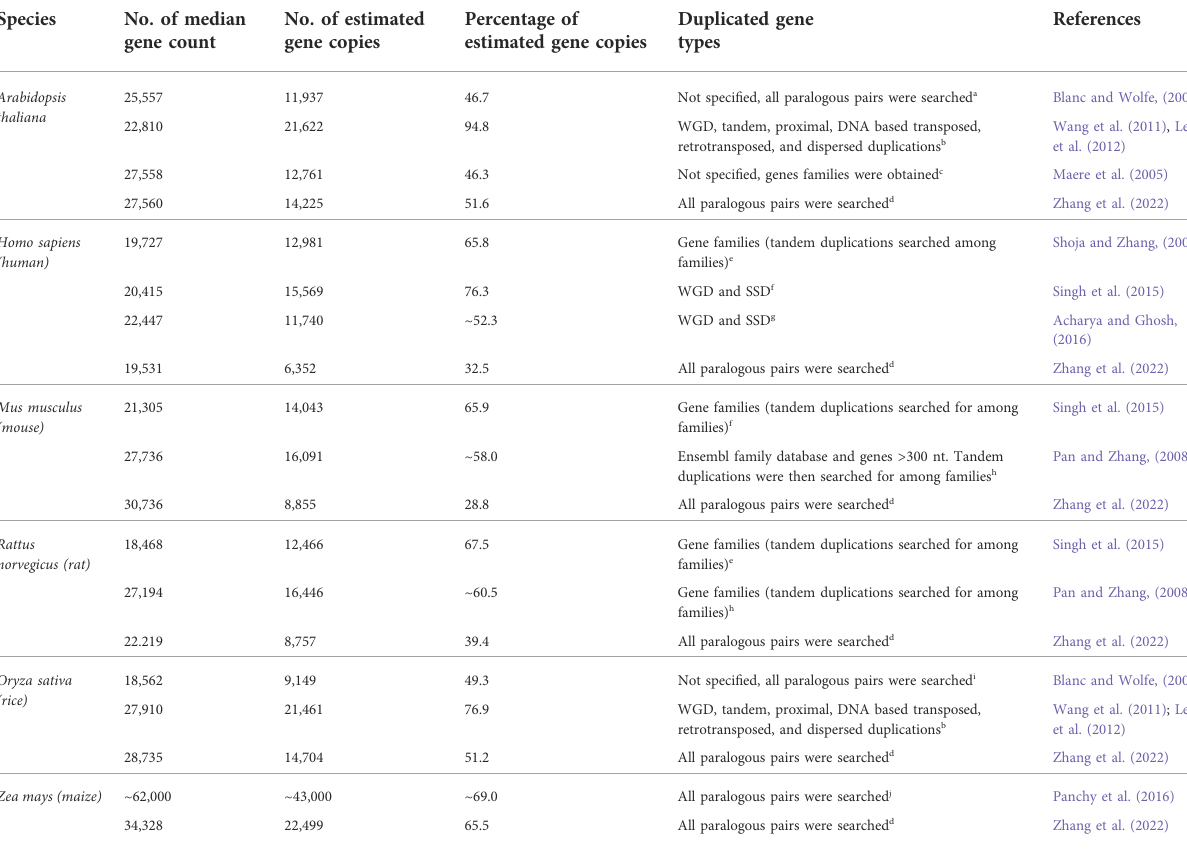
a All-against-allnucleotidesequencesimilaritysearchesusingBLASTN,amongthetranscribedsequences.Sequencesalignedover > 300 bpandshowingatleast40%identitywerede fi nedas pairs of paralogs. b All-against-all protein sequence similarity search using BLASTP (top fi ve non-self protein matches with E-value of 1e-10 were considered). Genes without hits that met a threshold of E-value 1e-10 weredeemed singletons. Single gene duplicationswerederived by excludingpairs of WGD,duplicates fromthe populationof gene duplications. Tandemduplicationswere de fi nedasbeingadjacenttoeachotheronthesamechromosome.Proximalduplicationswerede fi nedasnon-tandemgenesonthesamechromosomewithnomorethan20annotatedgenes between eachother. Single gene transposed-duplications were searched for fromthe remainingsingle gene duplicationsusing syntenicblocks withinand between 10 species to determine the ancestral locus. If the parental copy had more than two exons and the transposed copy was intronless, the pair of duplicates was classi fi ed as coming from a retrotransposition. Other cases of single gene-transposed duplications were classi fi ed as DNA-based transpositions. Dispersed duplications corresponded to the remaining duplications not classi fi ed as